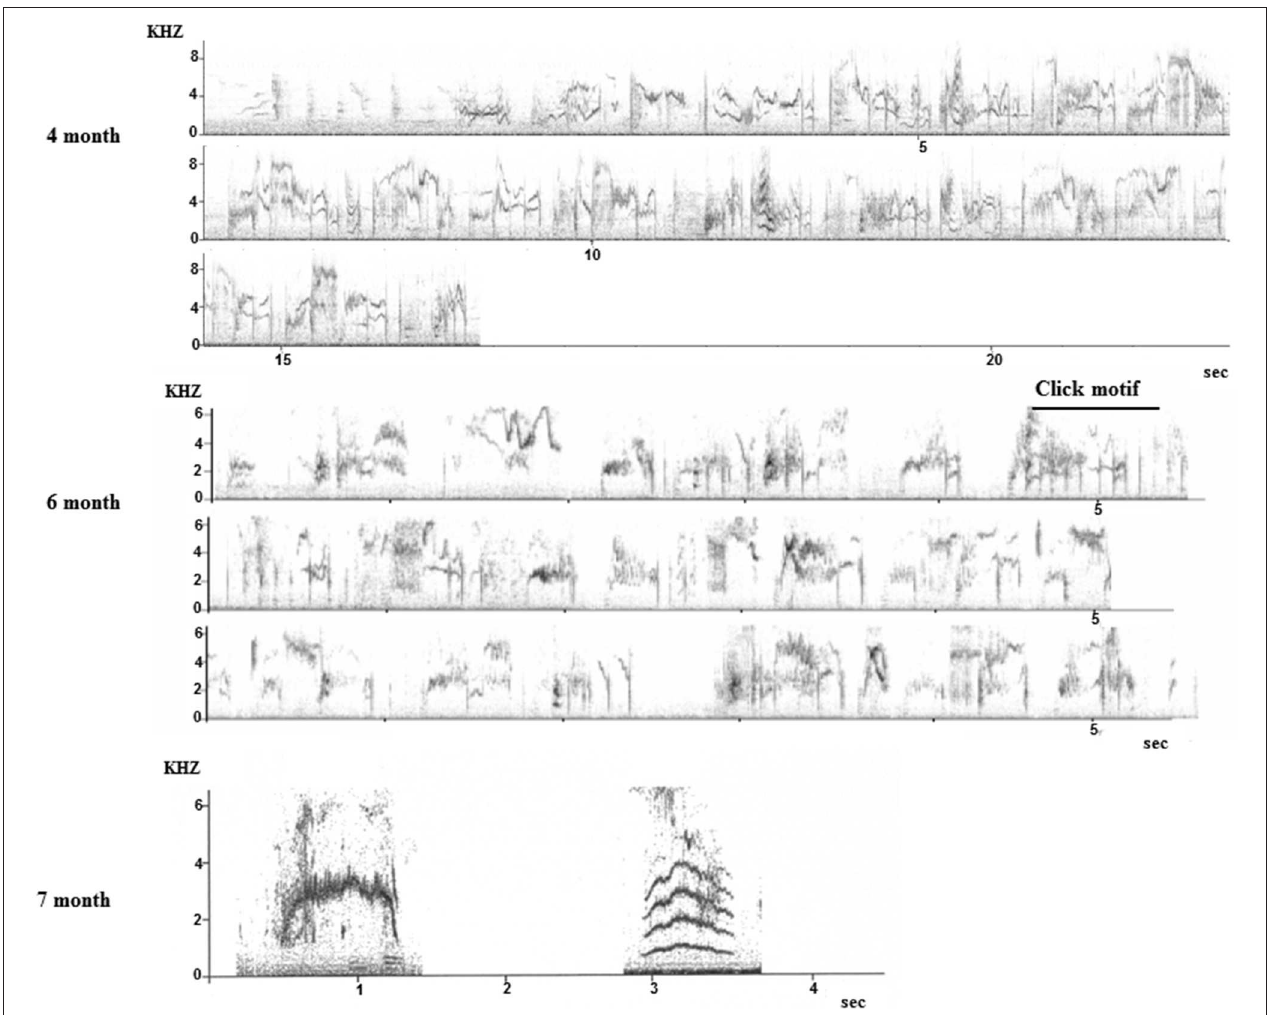
FIGURE 7 | Sonograms of song produced by young starlings during the first year. Top : subsong produced during the first summer (4 months old). Middle , sequence produced at 6 months: click motifs are recognizable. Bottom : two whistles recorded at 7 months old.